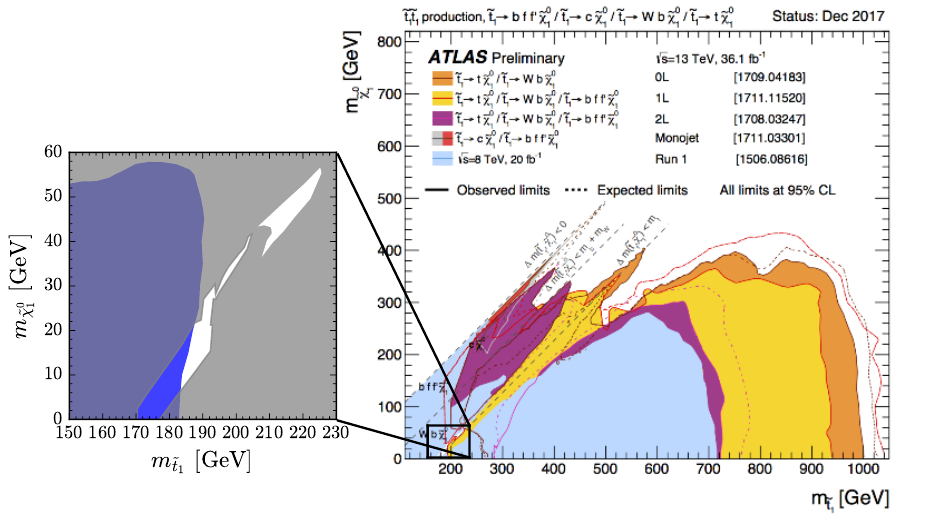
Figure 1 . The blue region in the breakout box shows the results of our recast. The gray region summarizes the ATLAS constraints, not including the t (cid:22) t spin correlation constraint, or the (cid:27) t (cid:22) t contamination constraint (which is the subject of this paper)